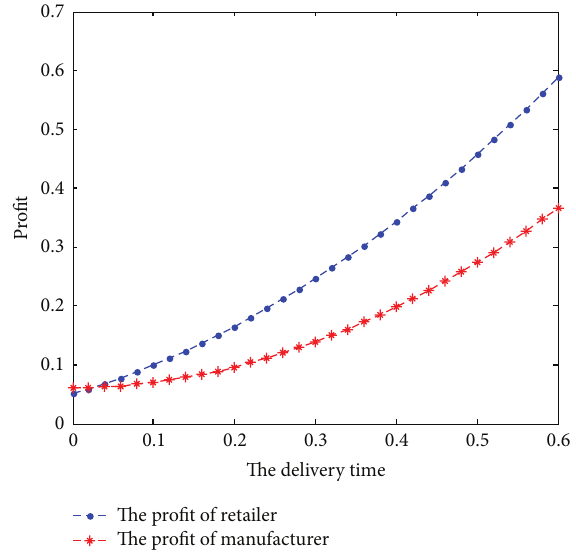
Figure 5: Effect of the delivery time on each player’s profit under Nash